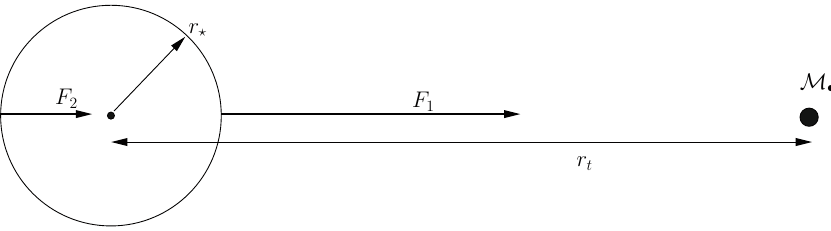
Fig. 1 Decomposition of the tidal forces over a star. The tidal radius is r t , M • the mass of the MBH and F 1 , F 2 the forces exerted on two points of the star which are diametrically